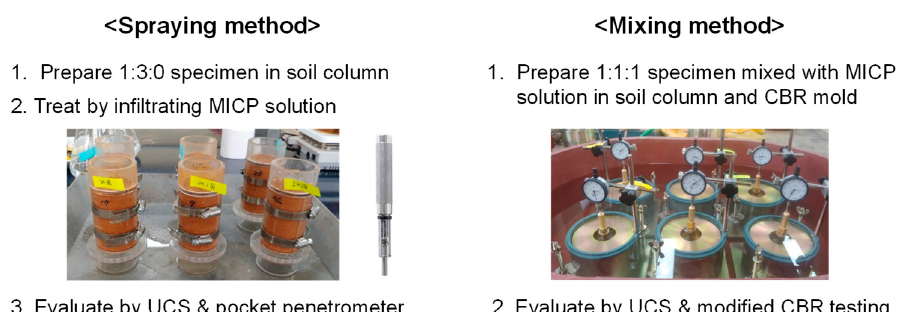
Figure 4. Brief scheme of experimental flow.